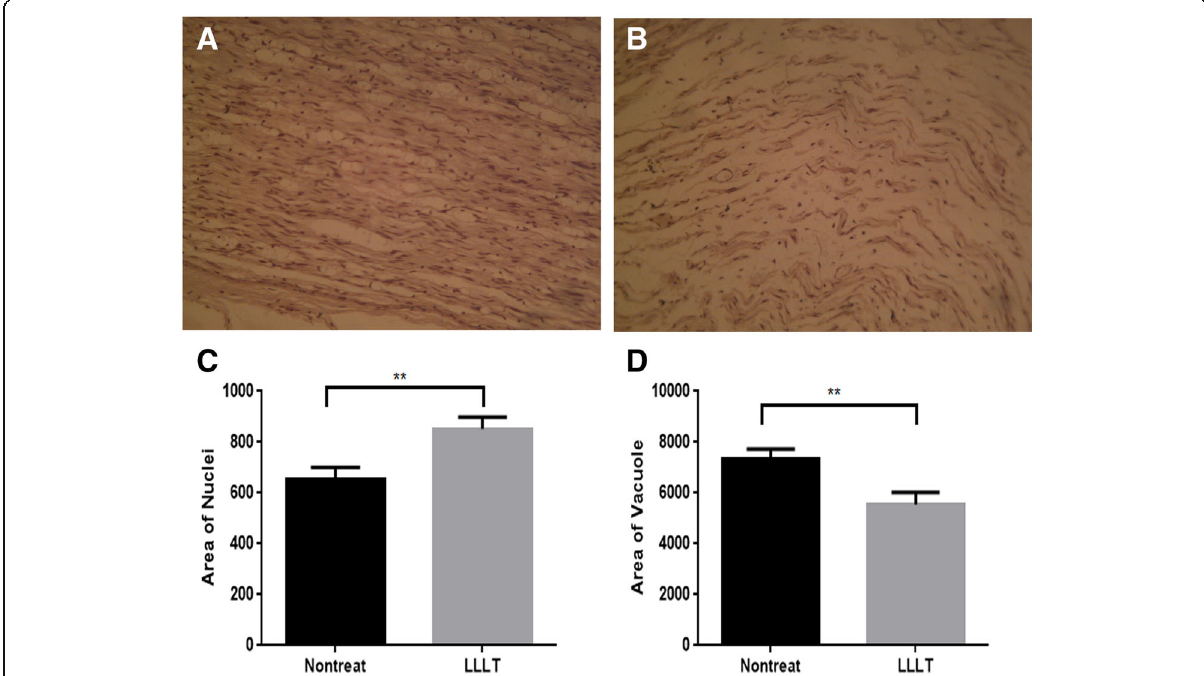
Fig. 3 Histopathological examination. a Longitudinal sections through the site of repair exhibited sprouting of the axons and enhanced alignment of nerve fibers at the site of laser irradiation. 100× H&E. b Untreated control nerves revealed loss of axons (100×) H&E. c , d Longitudinal sections of sciatic nerves quantitative assessments for nuclei and vacuole formation. Sections of sciatic nerves gained from injured rabbits with non-treated and LLLT treatments. Quantitative analyses for Schwann cells nuclei and vacuoles formation showing enhancement in repair and healing for the treated nerve with significant changes between each other at a confidence level of p <0.05.